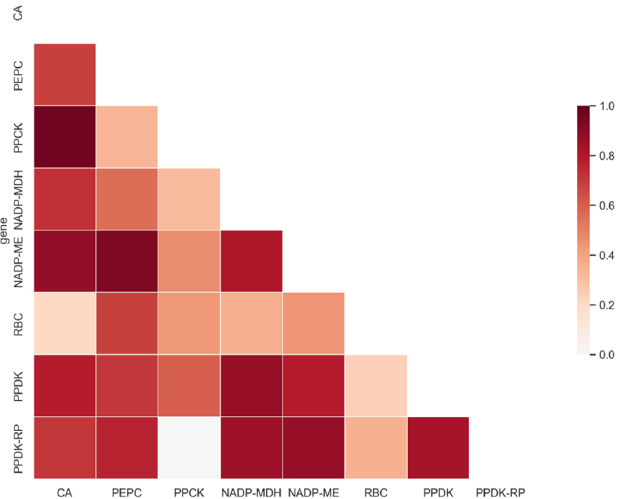
Figure 4. Heatmap diagram of co-evolved protein candidates calculated by Mirrortree server in carbon-delivery chain. Pairwise phylogenetic-tree-similarities measurement of selected enzymes. The red blocks show pairwise similarities. The darker the color is, the greater the tree similarity is.